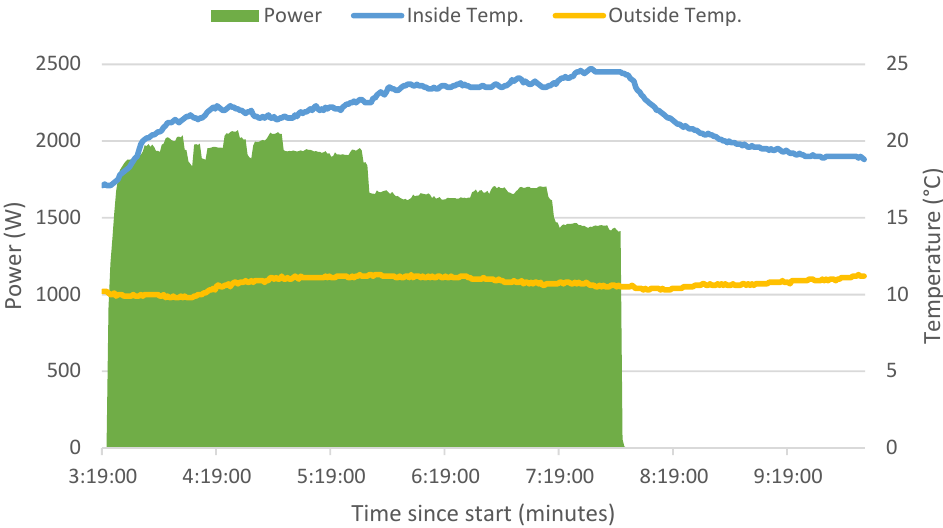
Figure 8. Test B: Power consumption, inside and outside temperature evolution over time.